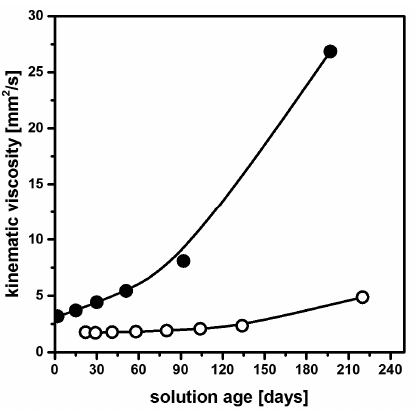
Figure 3. Viscosity of MgF 2 precursor solutions prepared from the reaction of Mg(OAc) 2 × 4H 2 O ( ● ) and dried Mg(OAc) 2 ( ○ ) with anhydrous HF as a function of sol age. Reproduced with permission from [43]. Copyright The Royal Society of Chemistry, 2015.